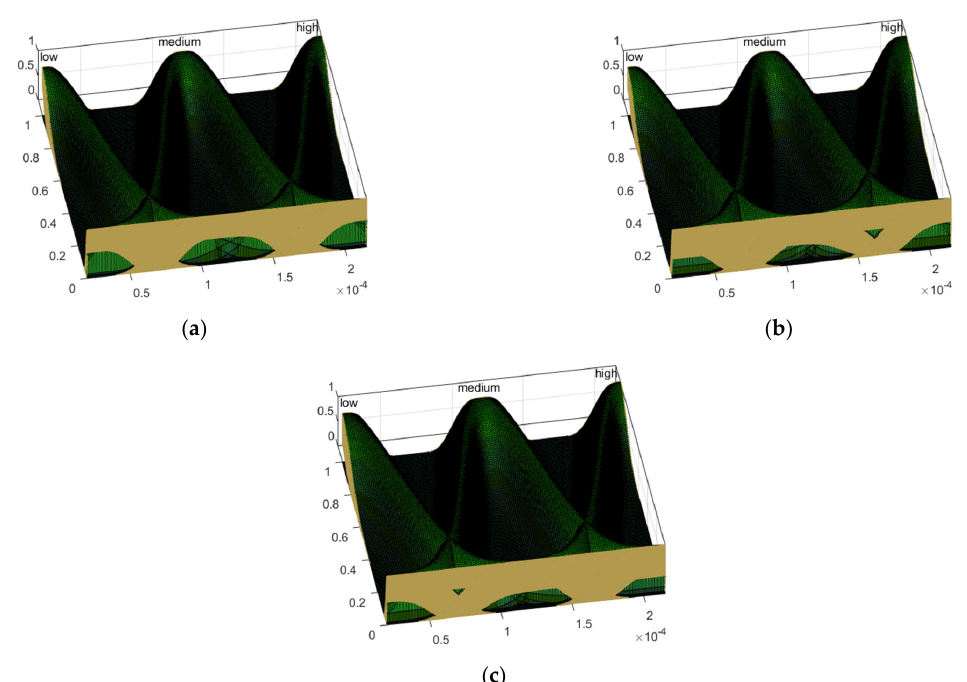
Figure 17. Best future prediction (China).